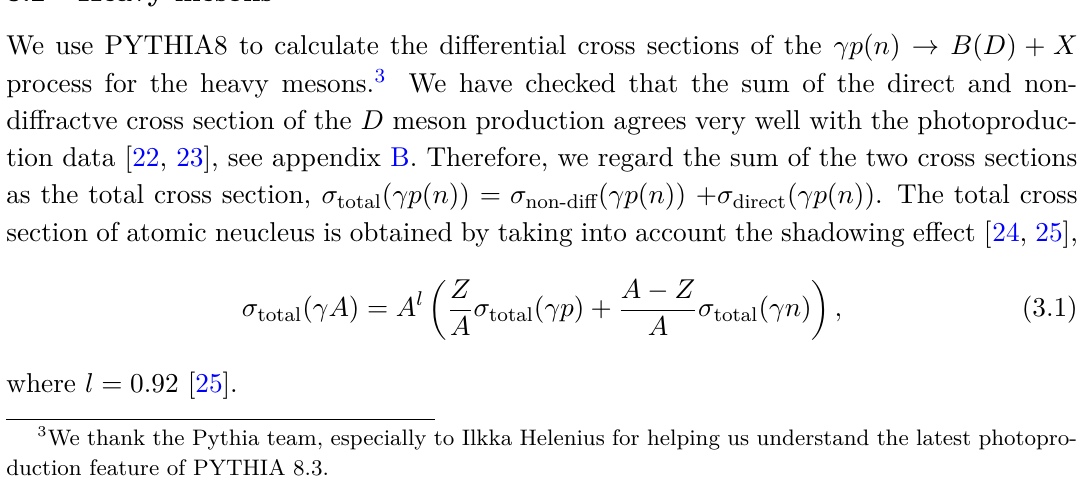
= 125 , 500 GeV beam